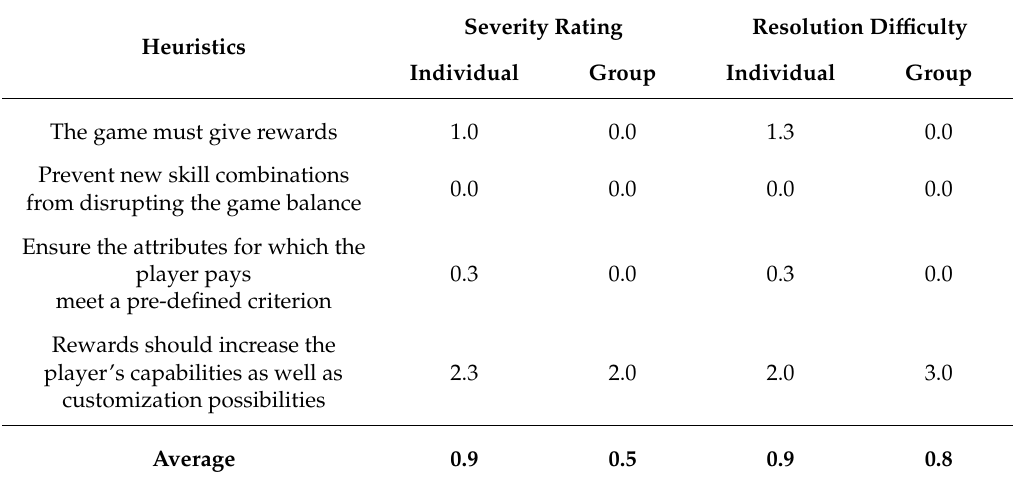
Table 3. Heuristics analysis of the game’s rewards [38].